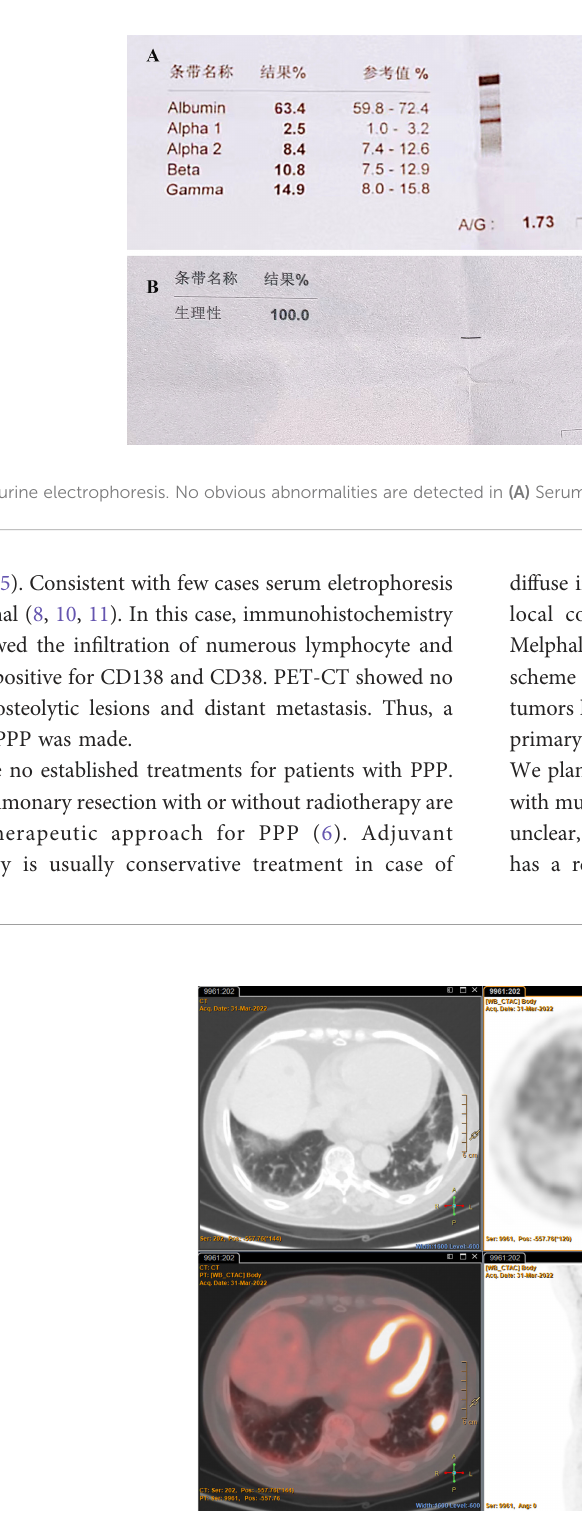
FIGURE 4 The Positron emission tomography-CT imaging characteristics shows a soft tissue density with hypermetabolism in the left lower lobe, but no abnormal metabolism in other organs and tissues, and no osteolytic